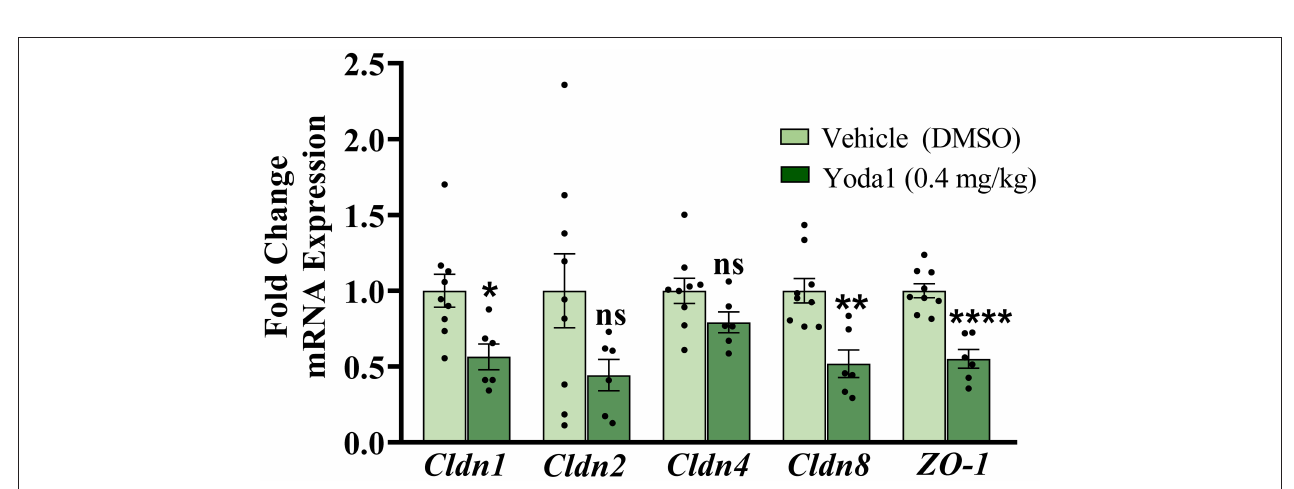
FIGURE 3 | (C,D) Urothelial cells from mice treated with 4 ( n = 5) and 24h ( n = 6) of CYP-induced cystitis showed increased Ca 2 + output when compared to their own baselines before PIEZO1 activation ( P ≤ 0.05 for both). (E) Urothelial cells from chronic CYP-treatment ( n = 6) showed variable Ca 2 + activity at baseline and no significant change in this activity following PIEZO1 activation. Values are means ± SEM. Statistical analyses were performed on using a paired Student’s t -test. * P ≤ 0.05.